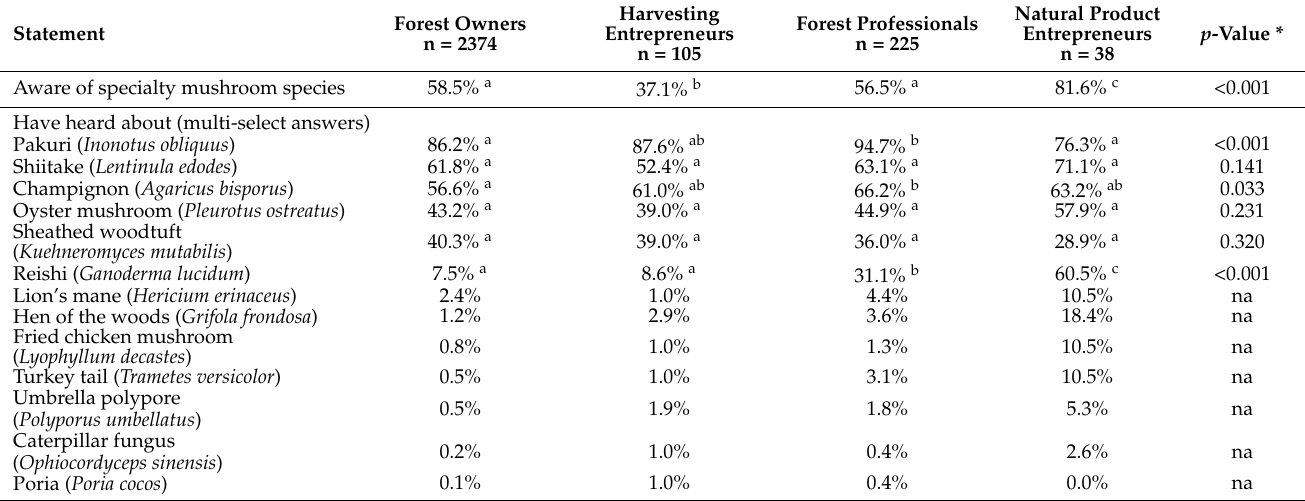
Table 9. Supply chain actors’ awareness of specialty